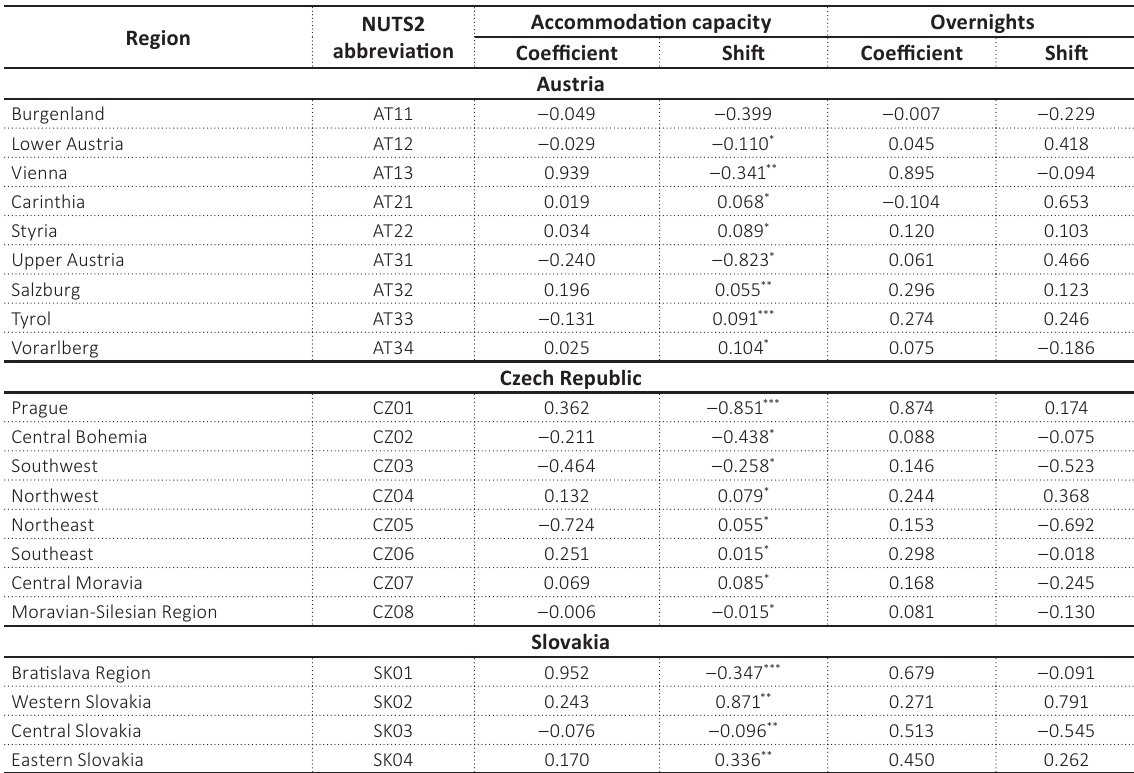
Table 3. Selected Central European countries for PLS coefficients of accommodation capacity vs. overnights and